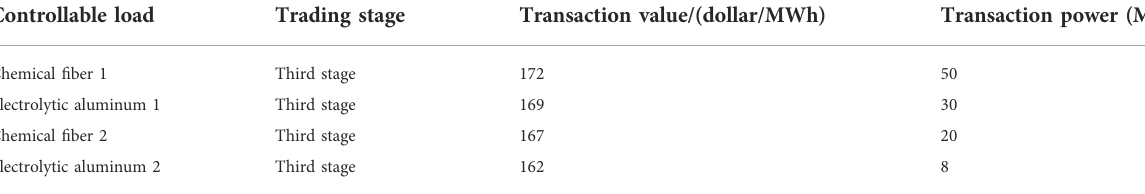
TABLE 5 Second round bidding results of controllable load enterprises.